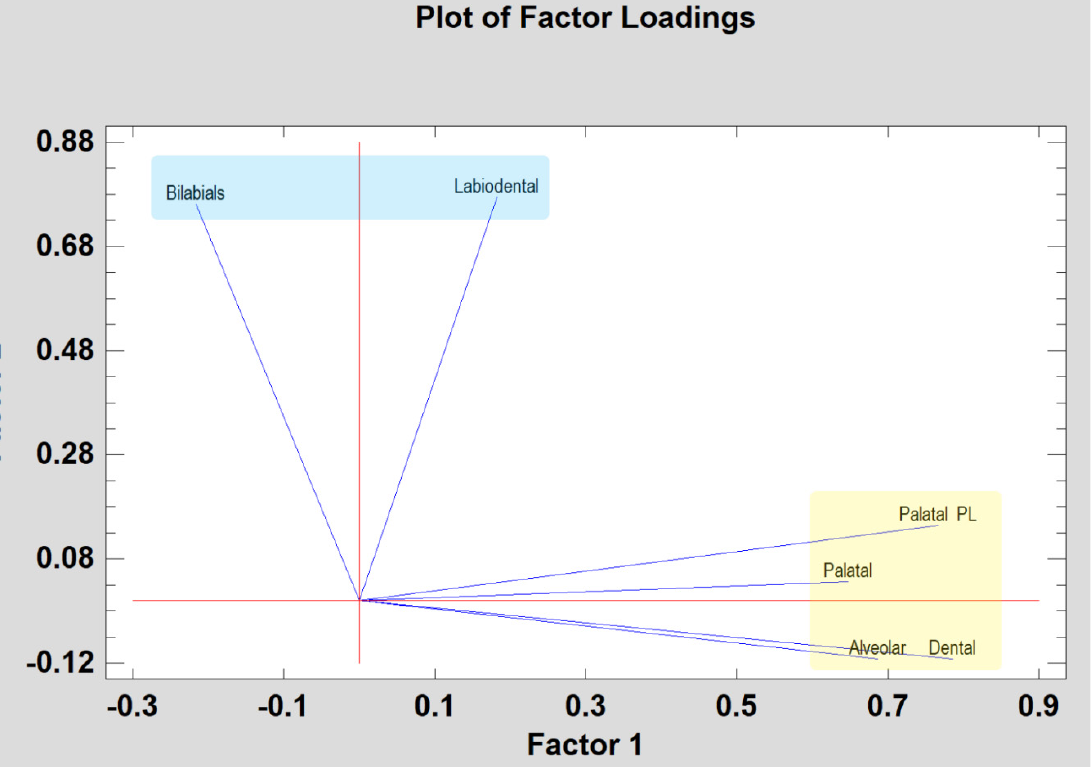
Figure 3. Components included in the two factors that achieved an eigenvalue higher than 1 (factor analysis). Factor 1 is called Skeletal Consonants (major components highlighted in yellow), and Factor 2 is called Soft Tissue Consonants (major components highlighted in blue). The data for 88 untreated patients.